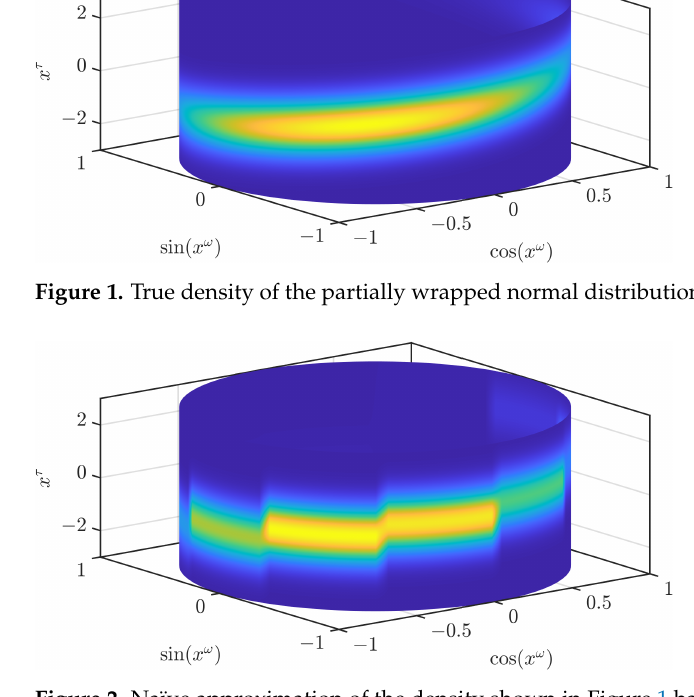
Figure 2. Naïve approximation of the density shown in Figure 1 based on a subdivision of the state space. 10 areas are used in this